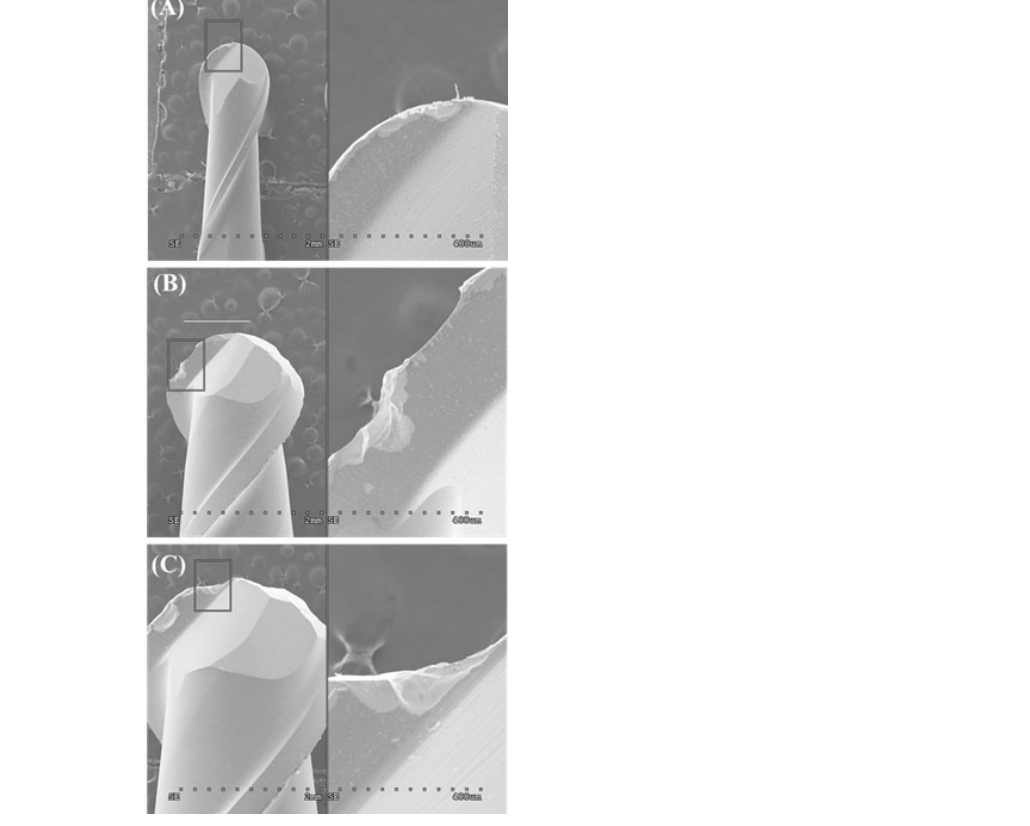
Figure 5. Edge chippings of milling burs with various diameters after milling of six three-unit FDPs. ( A ) 1.0 mm, ( B ) 2.0 mm, and ( C ) 3.0 mm.